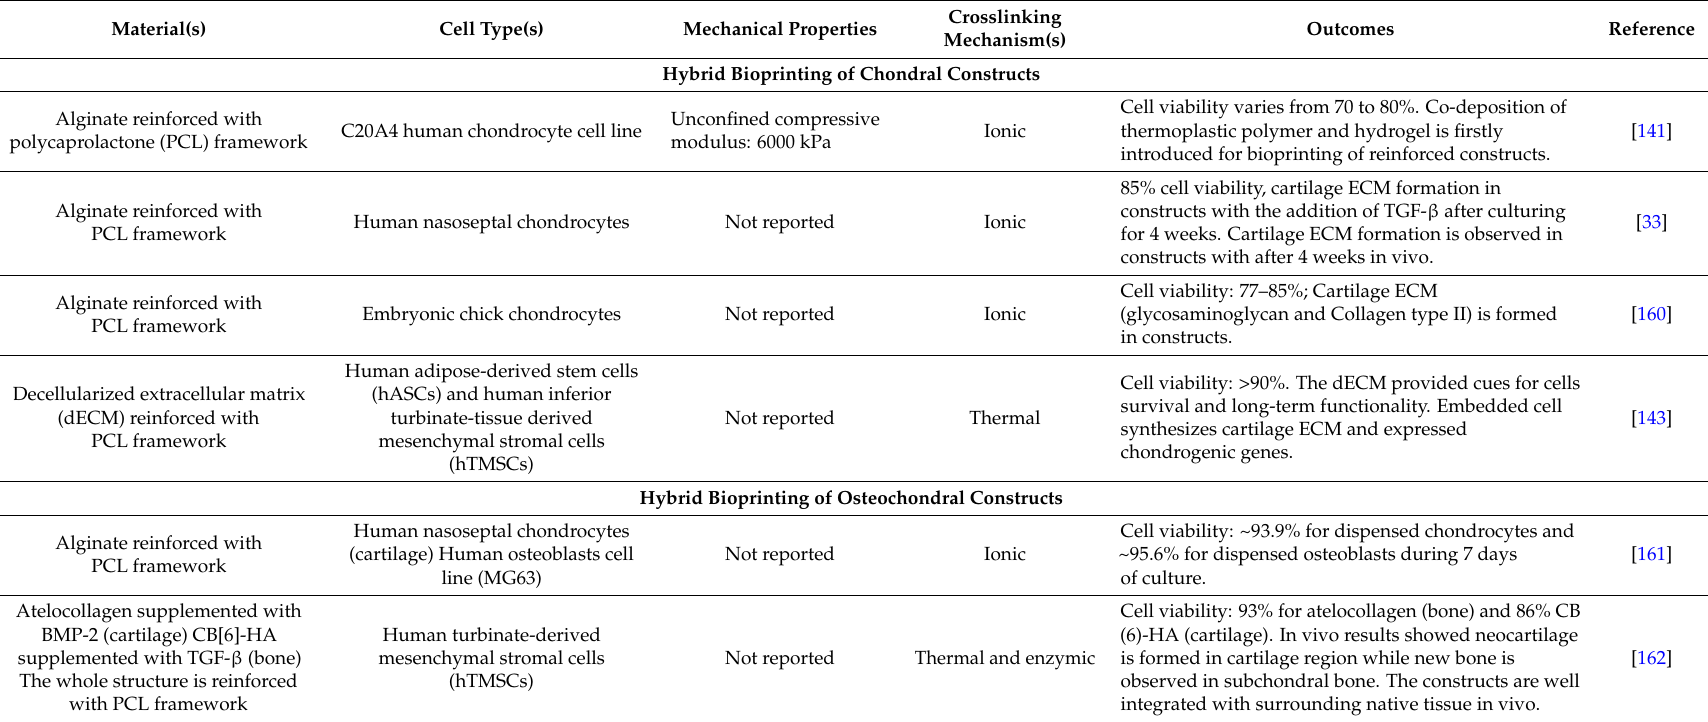
Table 4. Overview of publications on the hybrid bioprinting of osteo (chondral)